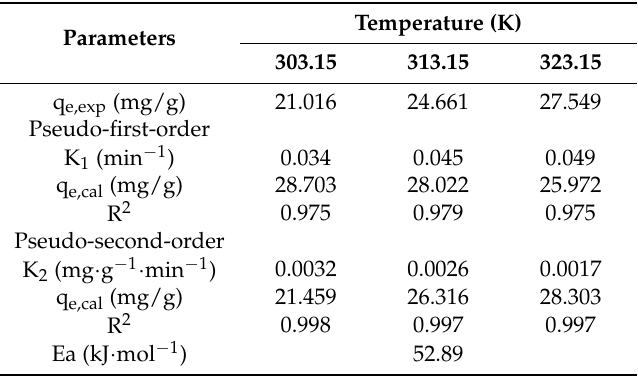
Figure 4. Fitting curves of ( a ) pseudo-first-order; and ( b ) pseudo-second-order. Table 1. Kinetic parameters of the adsorption BTB onto